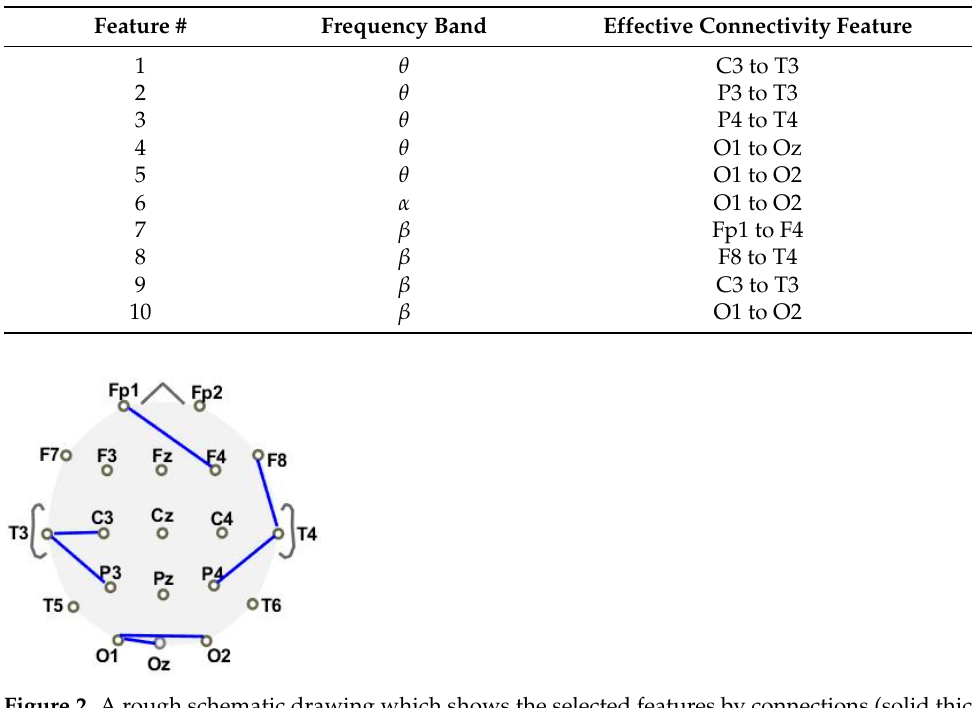
Table 2. The 10 discriminating features between SCZ and HC groups.